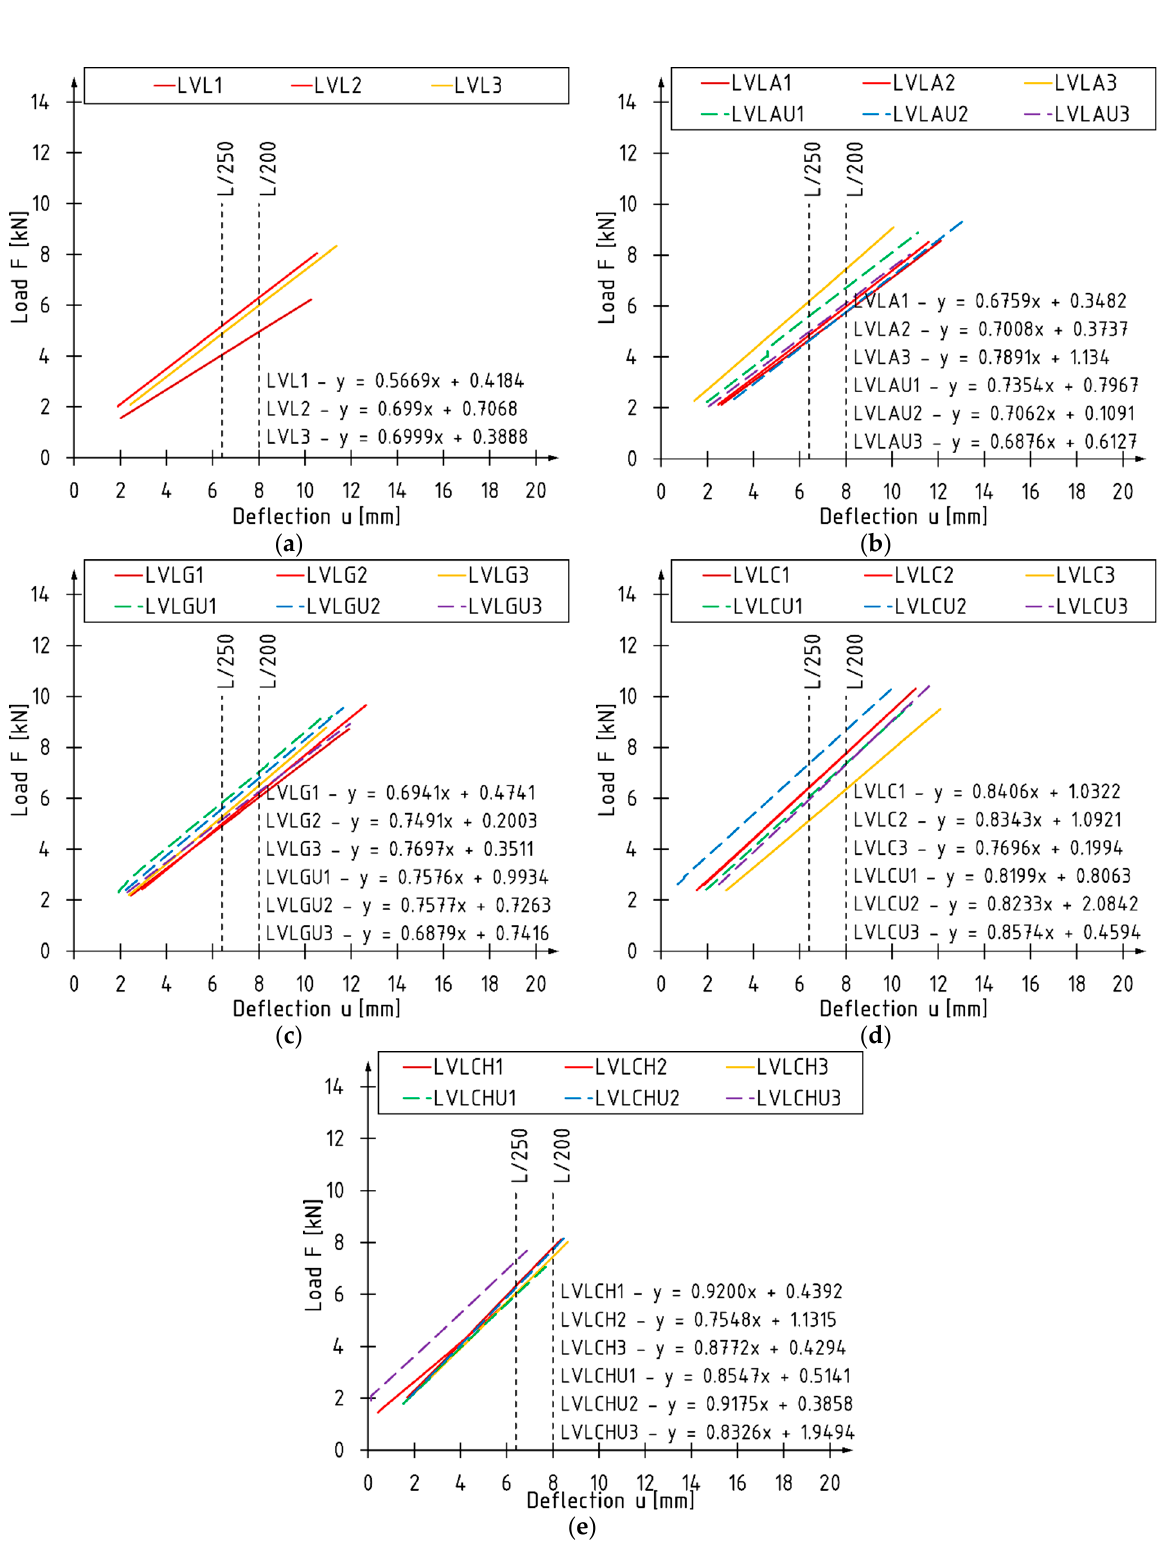
Figure 8. Section of load-deflection graphs between 0.1 Fmax and 0.4 Fmax: ( a ) LVL series; ( b ) LVLA/AU series; ( c ) LVLG/GU series; ( d ) LVLC/CU series; ( e ) LVLCH/CHU series.